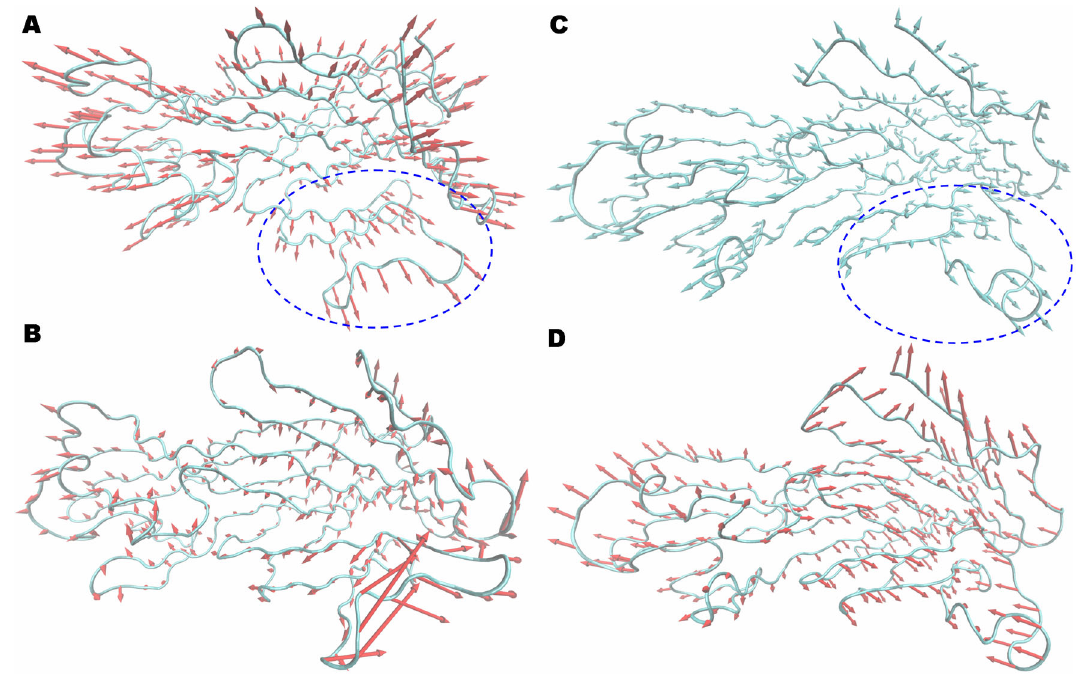
Figure 6. Collective motions obtained by principal component analysis on the simulation trajectory. (A) and (B) Motions corresponding to PC1 and PC2 of the unliganded a -HL, which account for 68.7 and 19.8% of the total movements, respectively. (C) and (D) Motions corresponding to PC1 and PC2 of the a -HL-OLG complex, which account for 65.4% and 18.7% of the total movements, respectively.